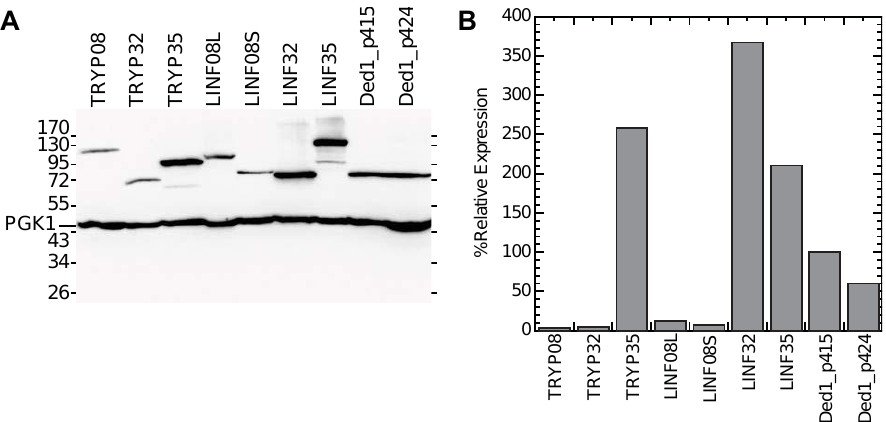
Figure 5. Expression of the proteins in yeast. The HA-tagged proteins in the p424 plasmid were expressed off the ADH promoter in the W303 yeast strain. ( A ) The proteins from the extracted cells were separated on a 10% SDS-PAGE, the separated proteins transferred to nitrocellulose membranes, and then visualized with IgG specific to the HA tag or PGK1. ( B ) The quantified values of the gels shown in ( A ). Variations in loading were adjusted relative to the PGK1, and then the values were normalized relative to the expression of HA-Ded1_p415.